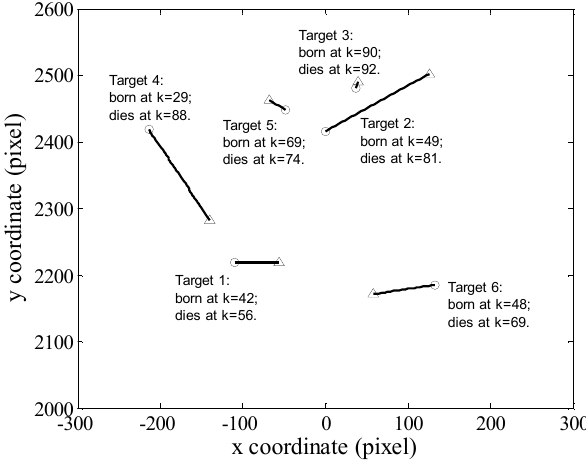
Figure 1. Target trajectories in the pixel plane with start/stop position as Ο / Δ